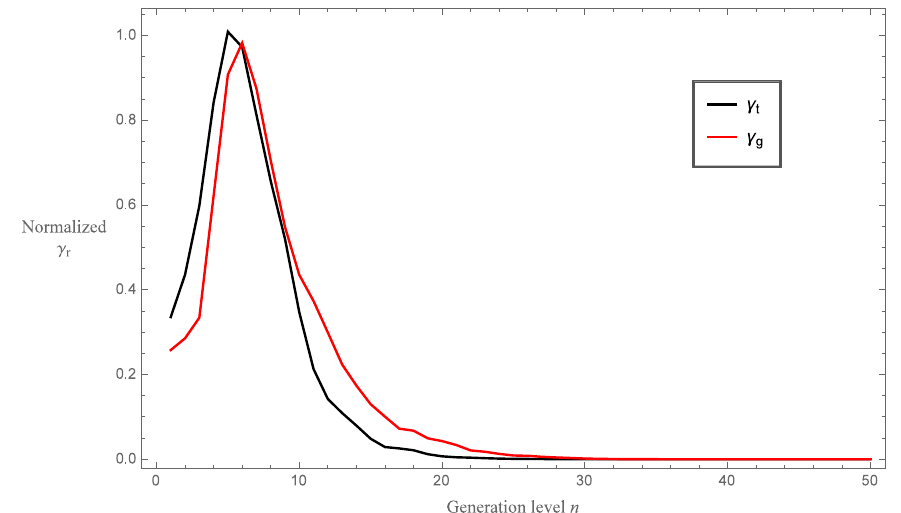
Figure 8. Normalized RFR for the Sierpinski tetrix ( γ t ) and Sierpinski gasket ( γ g ) devices as a function of fractal generation level n